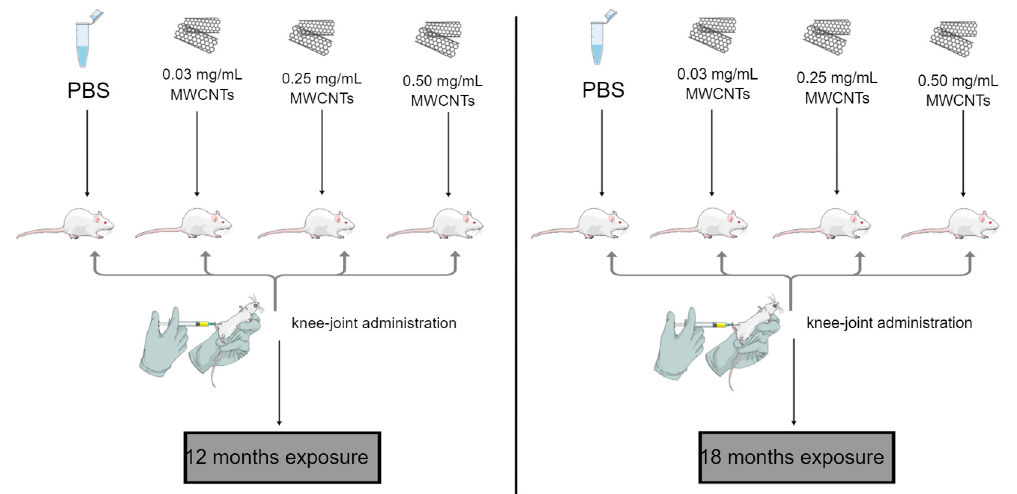
Figure 2. Schematic representation of the designed experiment.